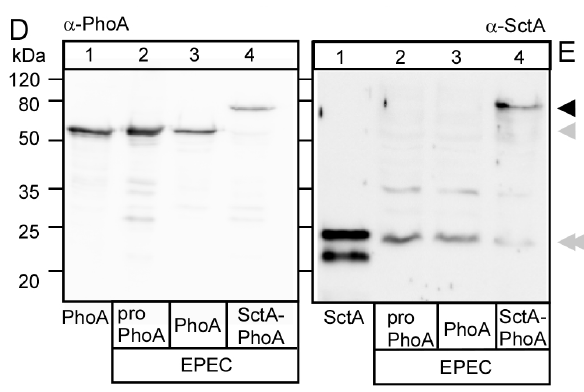
Figure 1. SctA-PhoA secretion by EPEC cells is not Sec-dependent. ( A ) Cartoon of the T3SS proteins forming an injectisome and a SecYEG channel. Letters indicate the protein name following the Sct nomenclature (i.e., V = SctV). Below the injectisome, the secretory choice of the indicated secretory proteins, signal sequences, and their localizations after secretion are shown. ( B , C ) Testing of Sec-dependent periplasmic and T3SS-dependent extracellular secretion of proPhoA, SctA-PhoA and PhoA in EPEC, respectively, as derived from PhoA enzymatic activity (see Materials and Methods). Arabinose (0.13 mM) was used to induce the production of PhoA derivatives and sodium azide (4 mM) to prevent SecA-mediated secretion, as indicated. Bar graphs with SEM are shown; n = 3 biological repeats. Unpaired parametric t -test was performed, *: p < 0.01. ( D , E ) Intracellular production of proPhoA, PhoA and SctA-PhoA in EPEC. Polypeptides were analyzed in 15% w / v acrylamide gels by SDS-PAGE, followed by immunostaining with α -PhoA and α -SctA (as indicated). Arrows indicated: SctA-PhoA (black); PhoA (grey); chromosomal SctA (double grey). Lanes 1: 100 ng of PhoA-His ( D ) and 100 ng SctA ( E ) purified as described [15,16], respectively. A representative image is shown; n = 3 biological